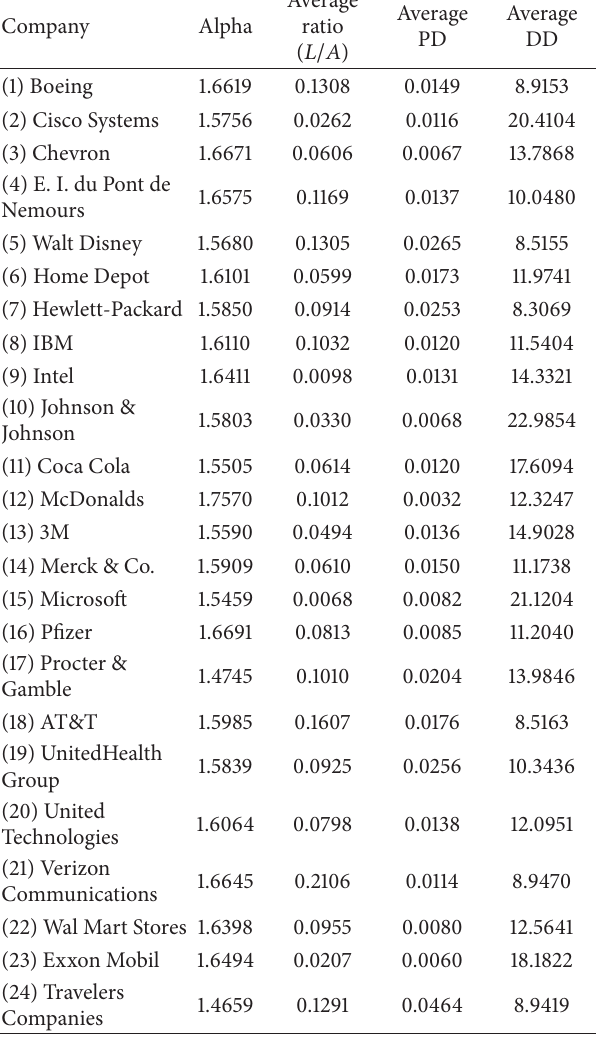
Table 3: Indexes of stability alpha average values of ratio ( 𝐿/𝐴 ), and risk neutral PD and DD obtained from the stable L´evy model.